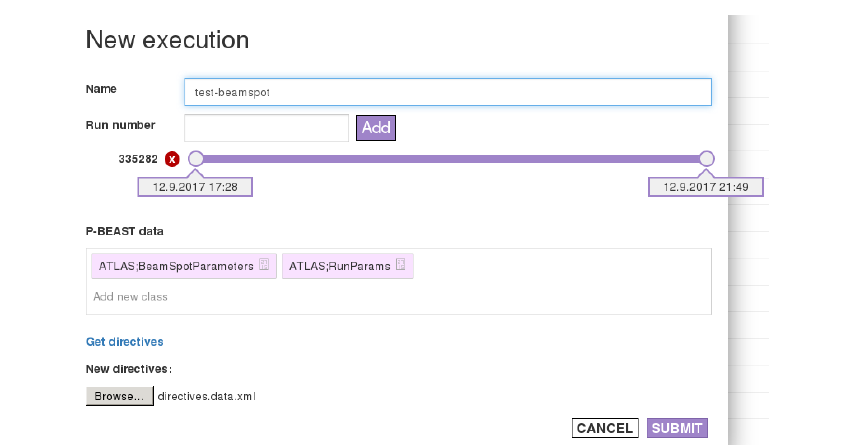
Figure 6. Screenshot of SA Replay web application